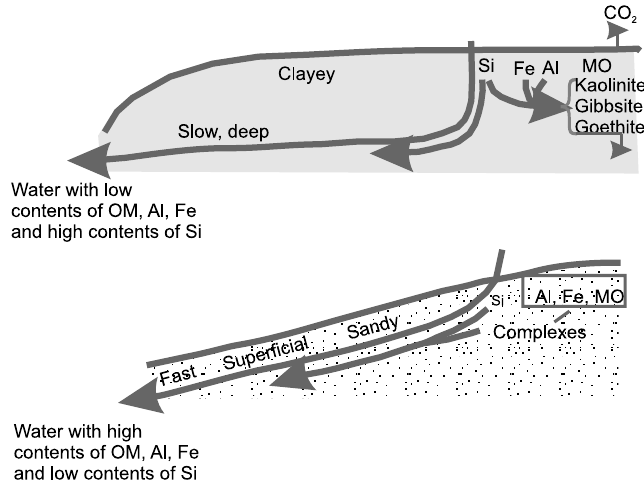
Fig. 8 – Hydrogeological of ferralic and podzolic